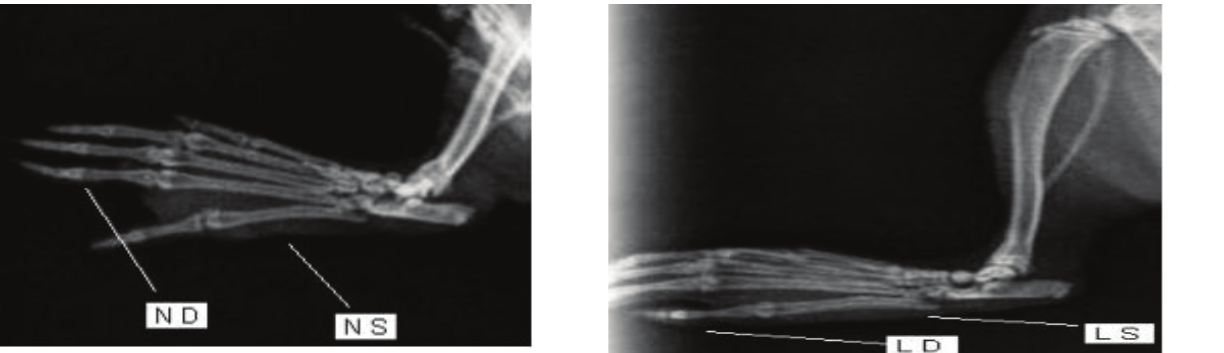
Fig-8: Therapeutic Group 8 Naproxen 25mg/kg treated rats showing no bony destruction and swelling of joint with reduced edema and swelling of soft tissues.